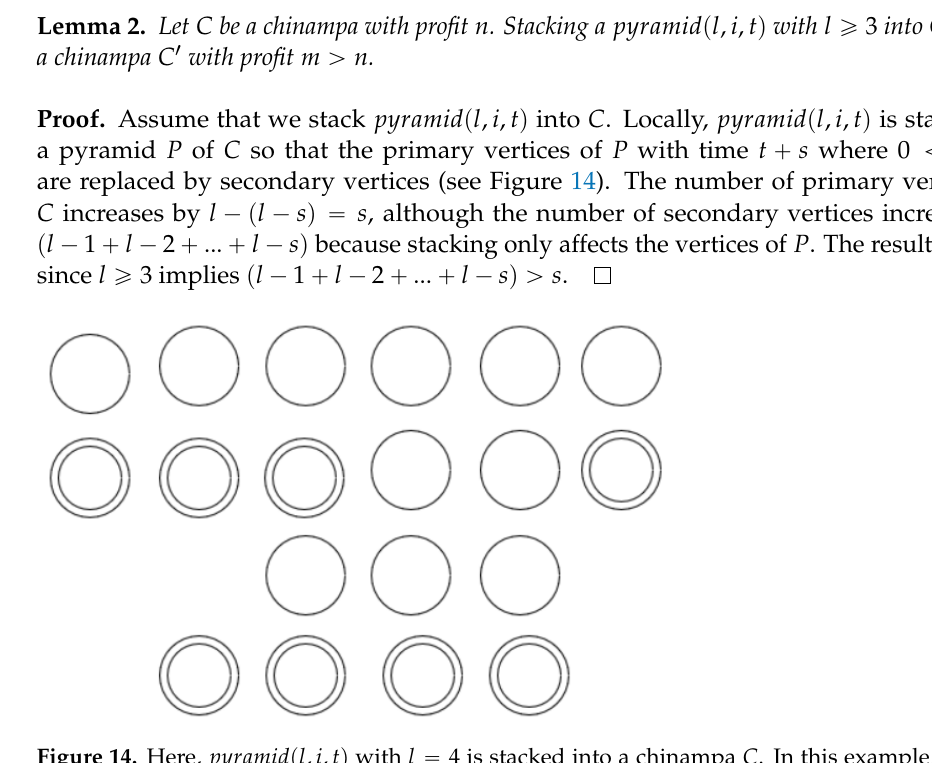
Figure 14. Here, pyramid p l , i , t q with l “ 4 is stacked into a chinampa C . In this example, the two primary vertices of C at t ` 2 become